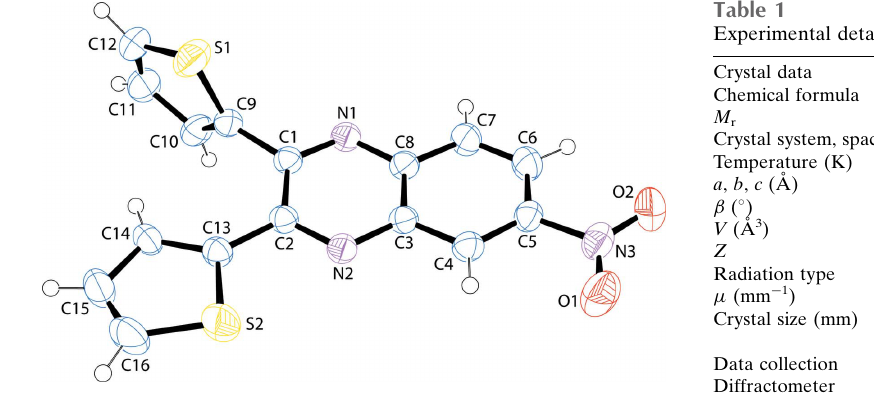
Figure 1 A view of 6-nitro-2,3-bis(thiophen-2-yl)quinoxaline (Farrugia, 2012). Displacement ellipsoids are drawn at the 50% probability